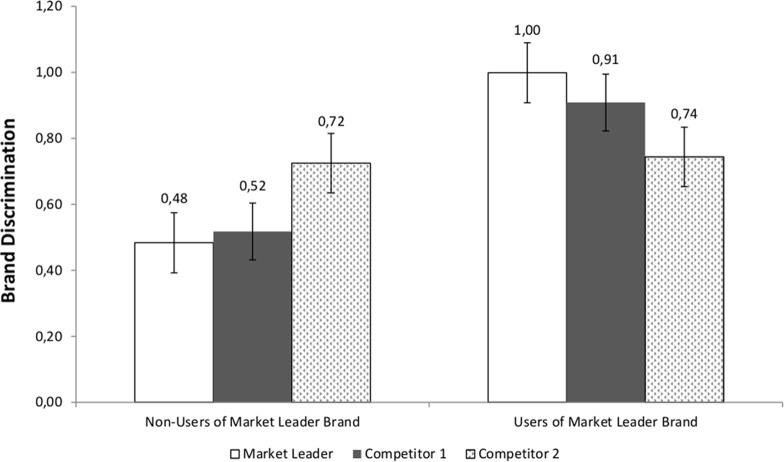
Brand Discrimination for the Market Leader brand and its two competitors for Non-Users and Users of the Market Leader Brand, Study 1 B.Note: Standard error bars are shown for each mean.